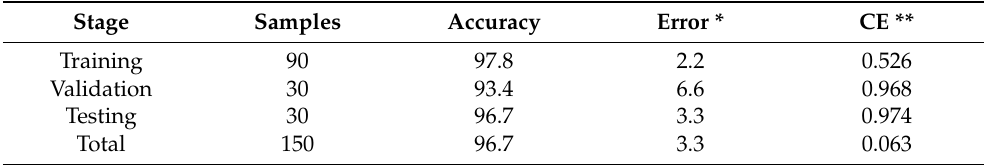
Table 9. Statistical results of the ANN classification models using the e-nose sensor array outputs for 10 cucumber treatment group samples based on the urea fertilizer